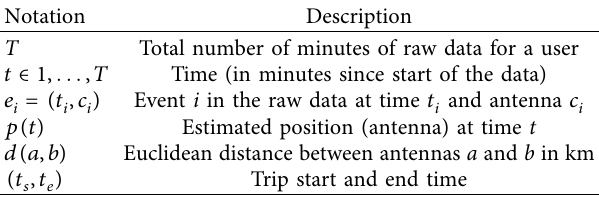
Table 2: Parameters used in the trip extraction